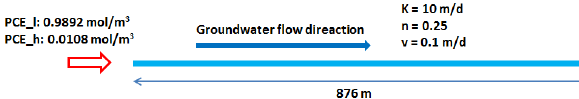
Figure 3. Model domain, material properties, and initial and bound- ary conditions of the isotope fractionation benchmark. K , n and v denote hydraulic conductivity, porosity and groundwater velocity of the aquifer, respectively (basic units are m (meter) and d (days)). Table 3. Initial and boundary conditions for the Engesgaard bench- mark.